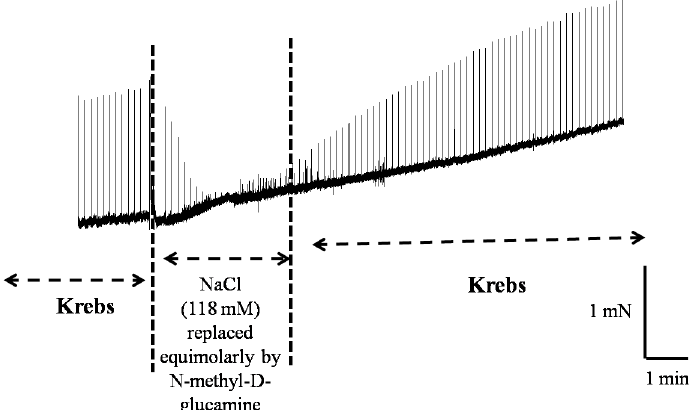
Fig 7. Representative illustration of EFS-induced contraction of Crotalus skeletal muscle in the presenceof Kreb’s solution modified (equimolar substitution of sodium chloride by N–methyl–D- glucamine)